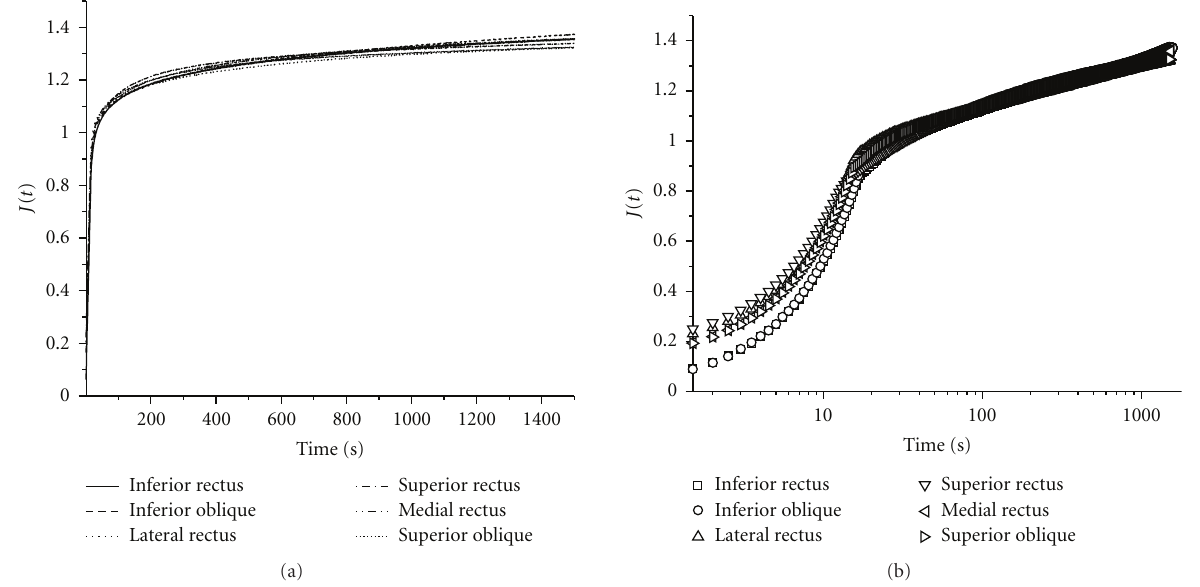
Figure 1: Mean normalized displacement J ( t ) plotted for two specimens each of the six bovine EOMs in both linear and semi-log scales. All EOMs exhibited similar creep to 1 . 34 ± 0 . 02 (SD) maximum.